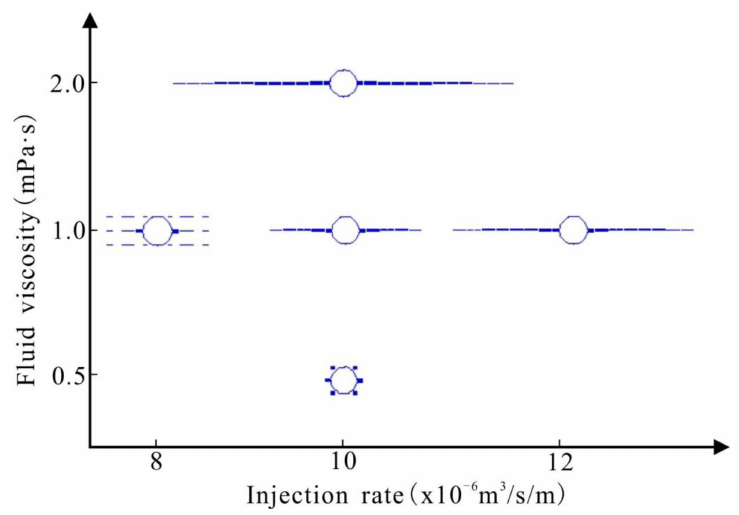
Figure 12. The relationship between injection rate and fluid